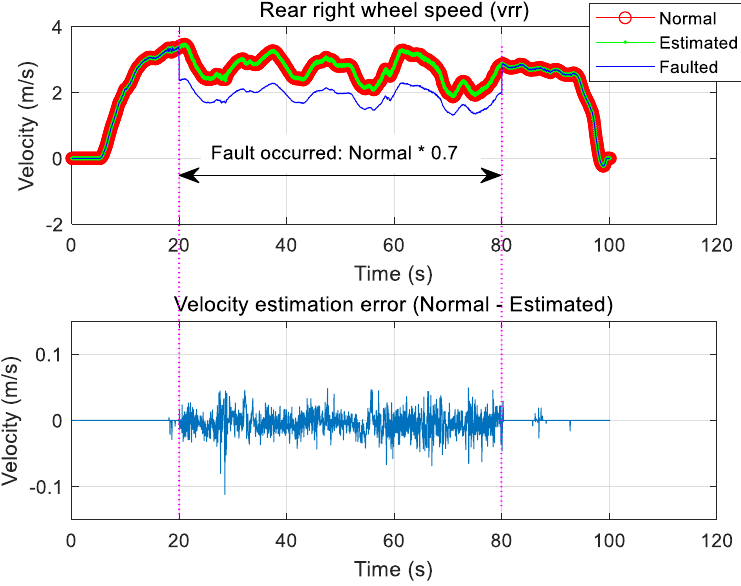
Figure 8. Type 2: Rear right wheel speed sensor fault and estimation.